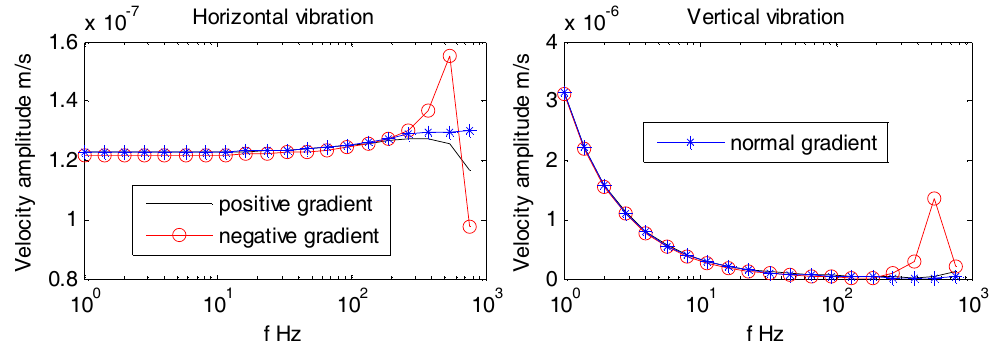
Figure 25. Vibration velocity amplitudes of the OBS with density gradients under incident angle of 10°.